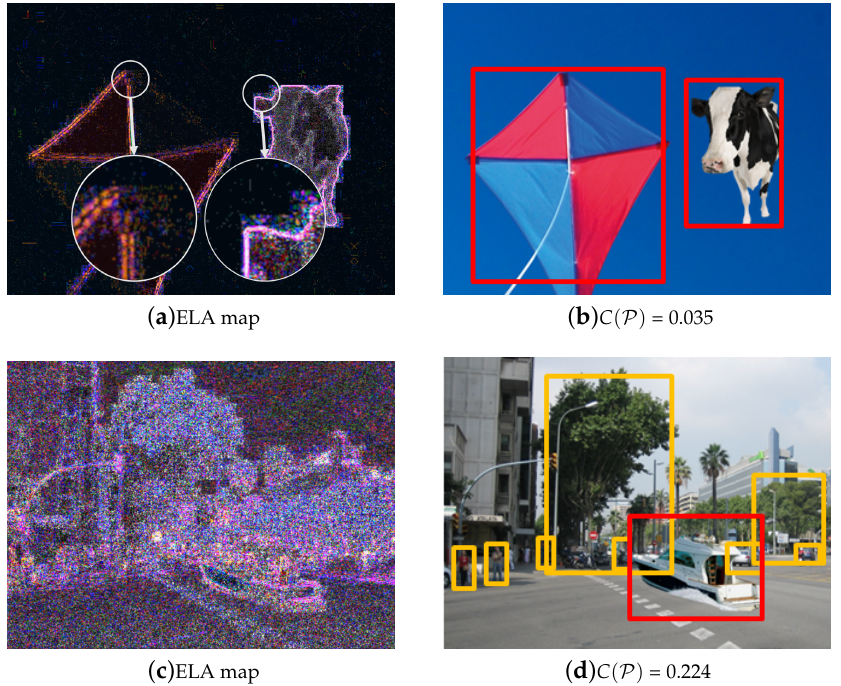
Figure 13. Error level analysis (ELA) highlights differences in the JPEG compression level. ( a ) ELA boost high-contrast edges from the cow that may have been digitally changed, but ( b ) the inserted cow cannot be distinguished by our detector. As an opposite sample, ( c ) ELA is unable to reveal the changed region when the image has been globally post-processed. ( d ) the proposed method confirms that a boat is out-of-context. The yellow box shows the normal detection results by R-CNN, and red box represent the detection result by our